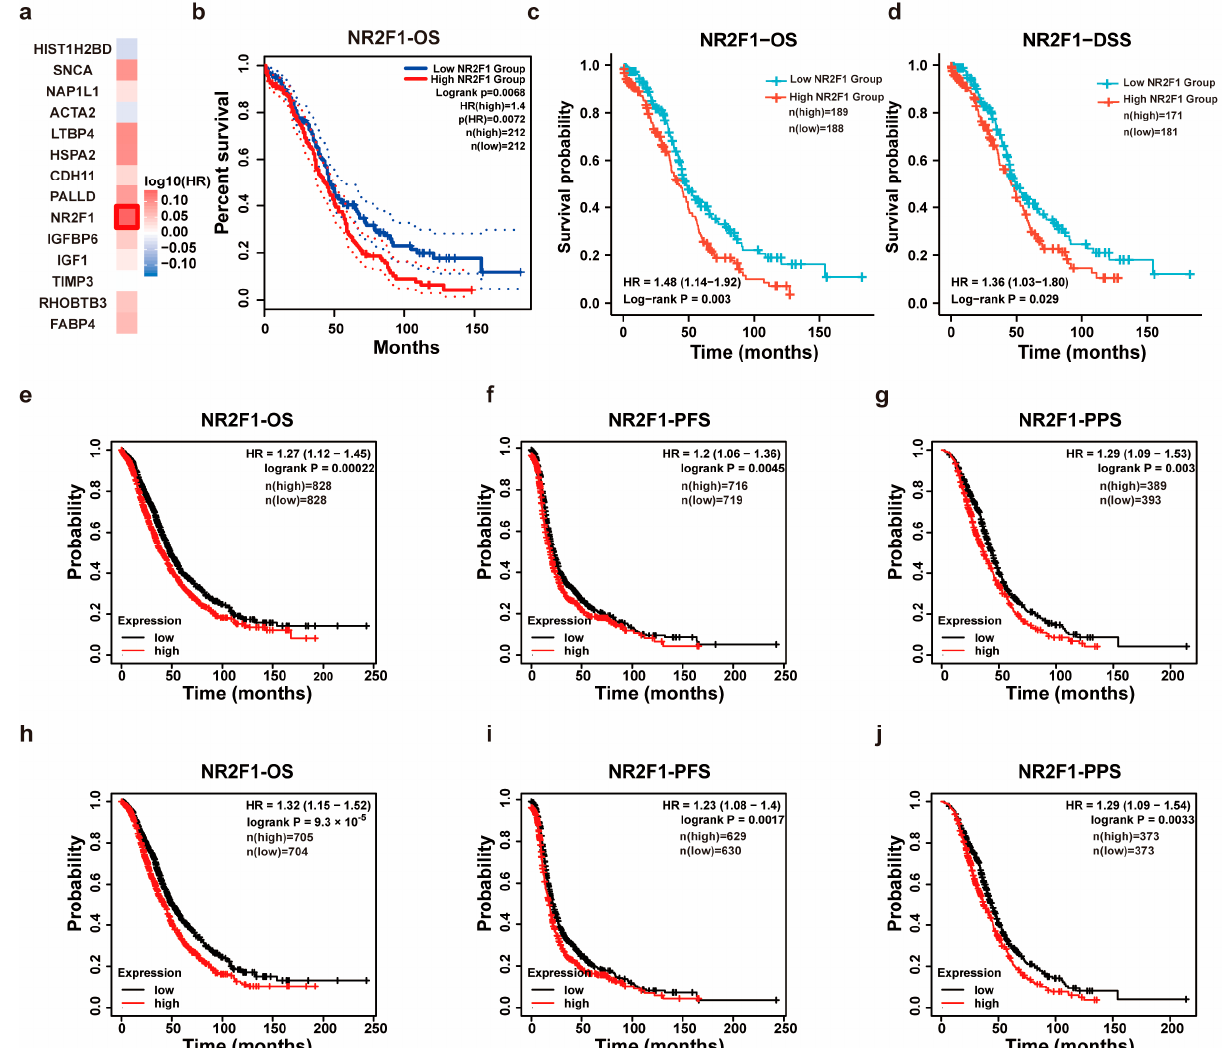
Figure 2. Prognostic significance of NR2F1 in OC. ( a , b ) Relationship between co-DEGs and overall survival (OS) by GEPIA2. Kaplan-Meier curve revealed the association of NR2F1 expression with OS. ( c , d ) The link of NR2F1 expression with OS, and disease-free survival (DSS) is based on Xiantao tool. ( e – j ) Kaplan-Meier survival analyses of NR2F1 on OS, progression-free survival (PFS) and post-progression survival (PPS) in OC patients ( e – g ), and in OC patients receiving platinum treatment ( h – j ).